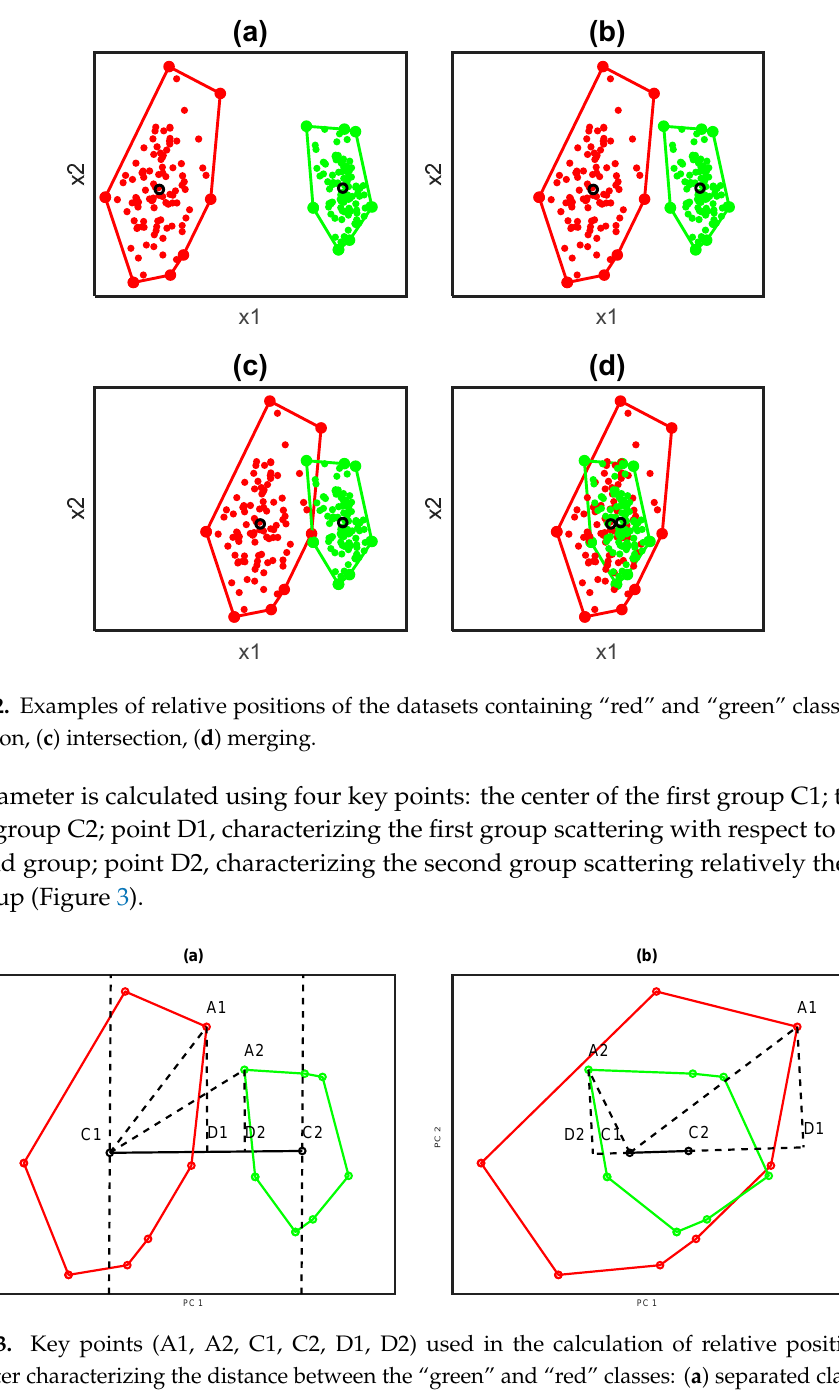
Figure 2b. When the classes are merged, their centers lie inside the intersection region, and when Sensors 2020 , 20 , x FOR PEER REVIEW the classes just intersected, their centers lie outside the intersection region.